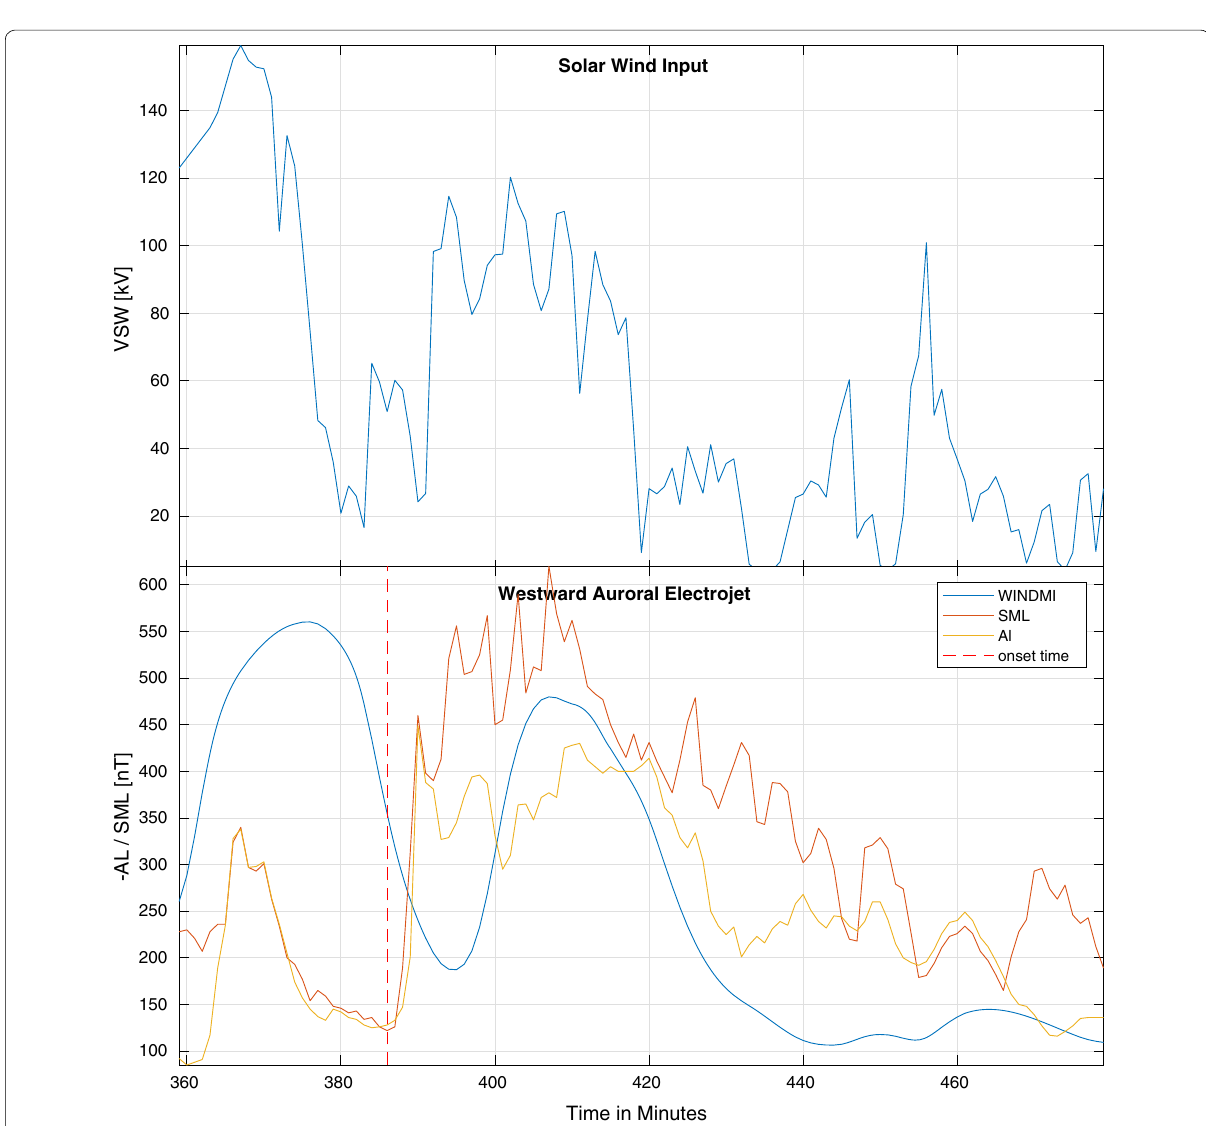
Fig. 2 Event 06:26 UT 22 February 2006: In the bottom panel, substorm onset time from auroral observations is depicted with the red-dotted line. The WINDMI model output is compared to the AL and SML indices. The top panel shows the solar wind input measured by the ACE satellite and propagated to the nose of the